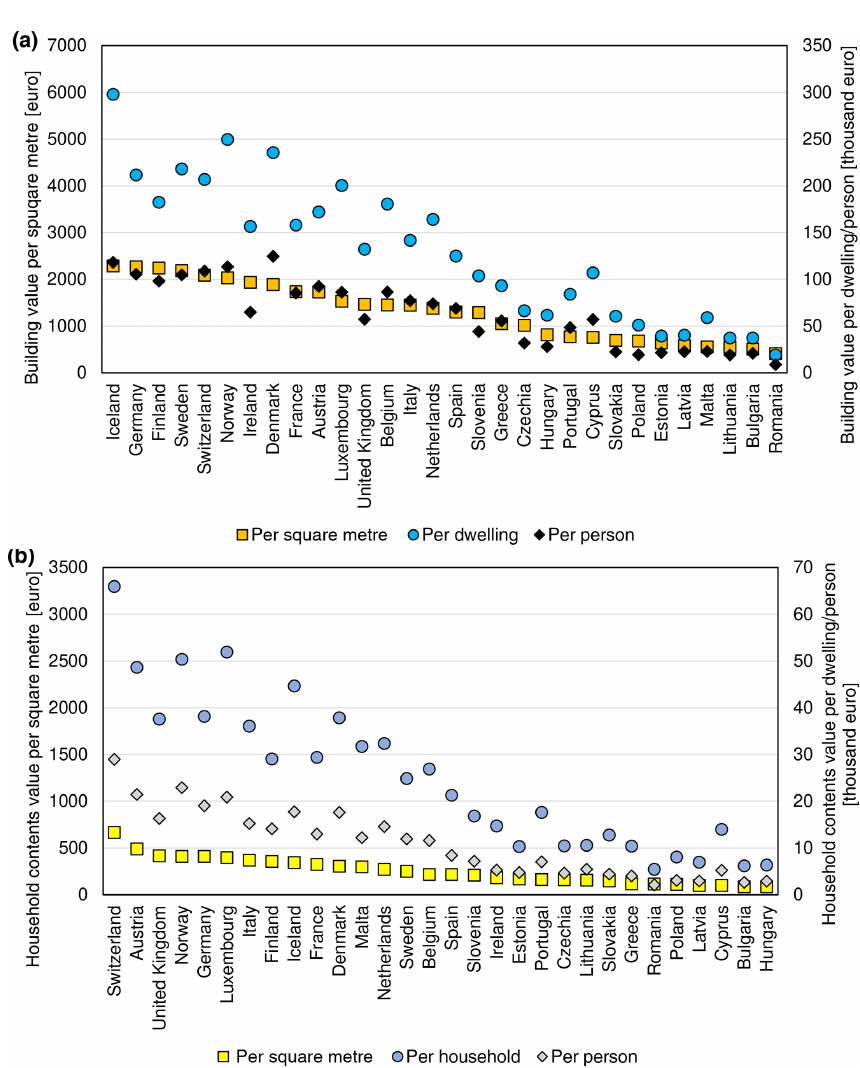
Figure 4. Value of (a) residential buildings and (b) household contents per square metre of floor space, per dwelling/household and per person, ranked by values per square metre of floor space, as of